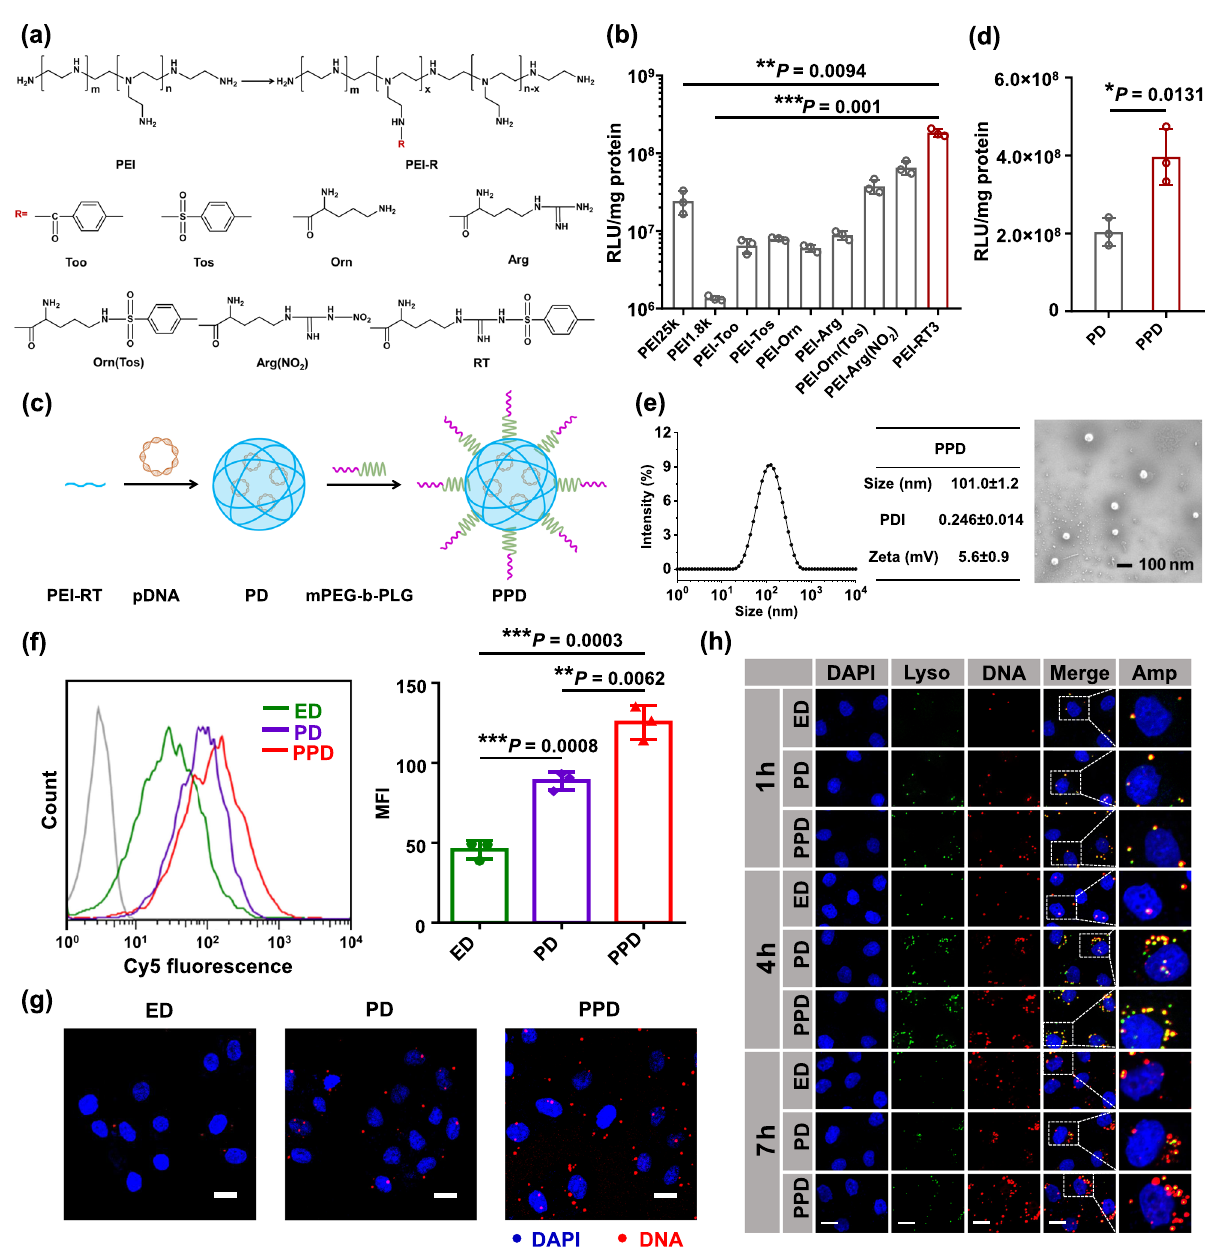
Fig. 2 Construction of ef fi cient polycationic gene carrier. a PEI modi fi ed with different ‘ molecular strings ’ . b Optimal DNA transfection ef fi ciency of PEI1.8k grafting with various ‘ molecular strings ’ in B16F10 cells. c Preparation diagram of PPD. d Optimal transfection ef fi ciency of PPD and PD in B16F10 cells. e Hydrodynamic particle size and scanning electron microscopy image of PD. f Cellular uptake of PD and PPD at 3h by fl ow cytometry in B16F10 cells. DNA was labeled with Cy5, ED was used as control. g Representative cellular uptake images of PPD, PD, and ED at 3h in B16F10 cells, scale bar: 20 μ m. h Representative endo/lysosomal escape images of PPD, PD, and ED at various time pointes (1, 4 and 7h) in B16F10 cells, scale bar: 20 μ m. Data in b , d , and f are presented as mean±SD, n = 3 biologically independent samples. P -values are calculated by the two-tailed Student ’ s t -test in b , d , and f as indicated in the fi gures. * P <0.05, ** P <0.01, and *** P <0.001. A representative image of three independent samples from each group is shown in e , g , and h . ED: PEI1.8k/DNA, PD: PEI-RT3/ DNA, PPD: